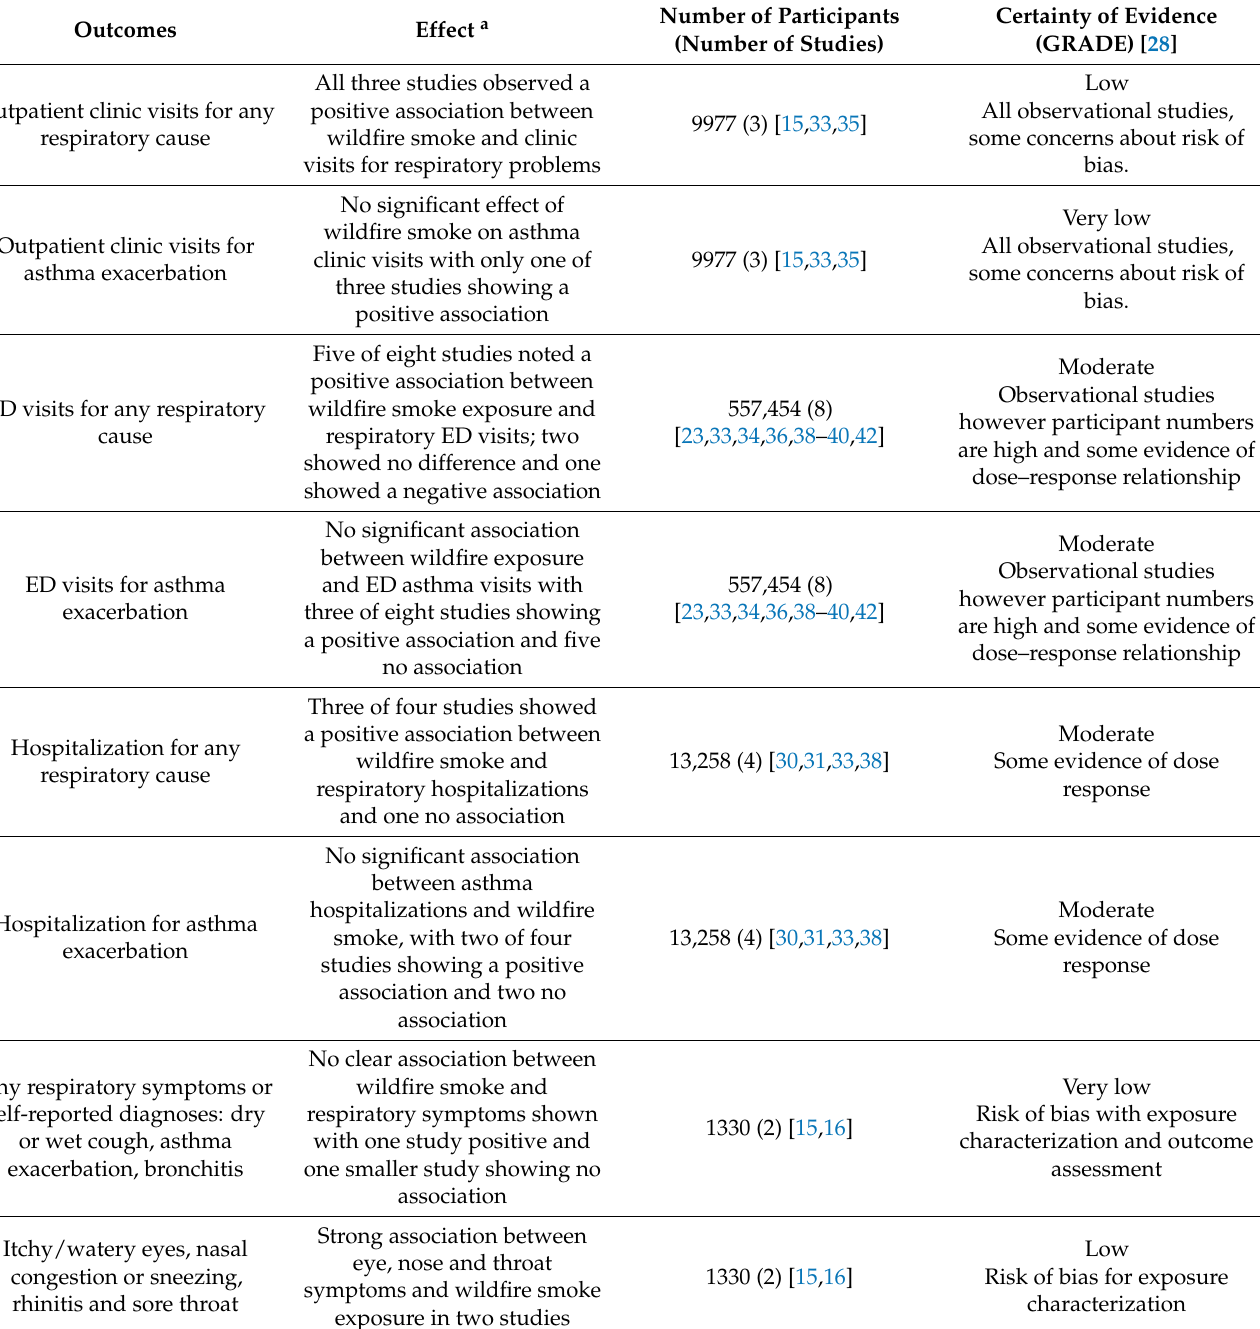
Table 3. Summary of findings with certainty of evidence (GRADE